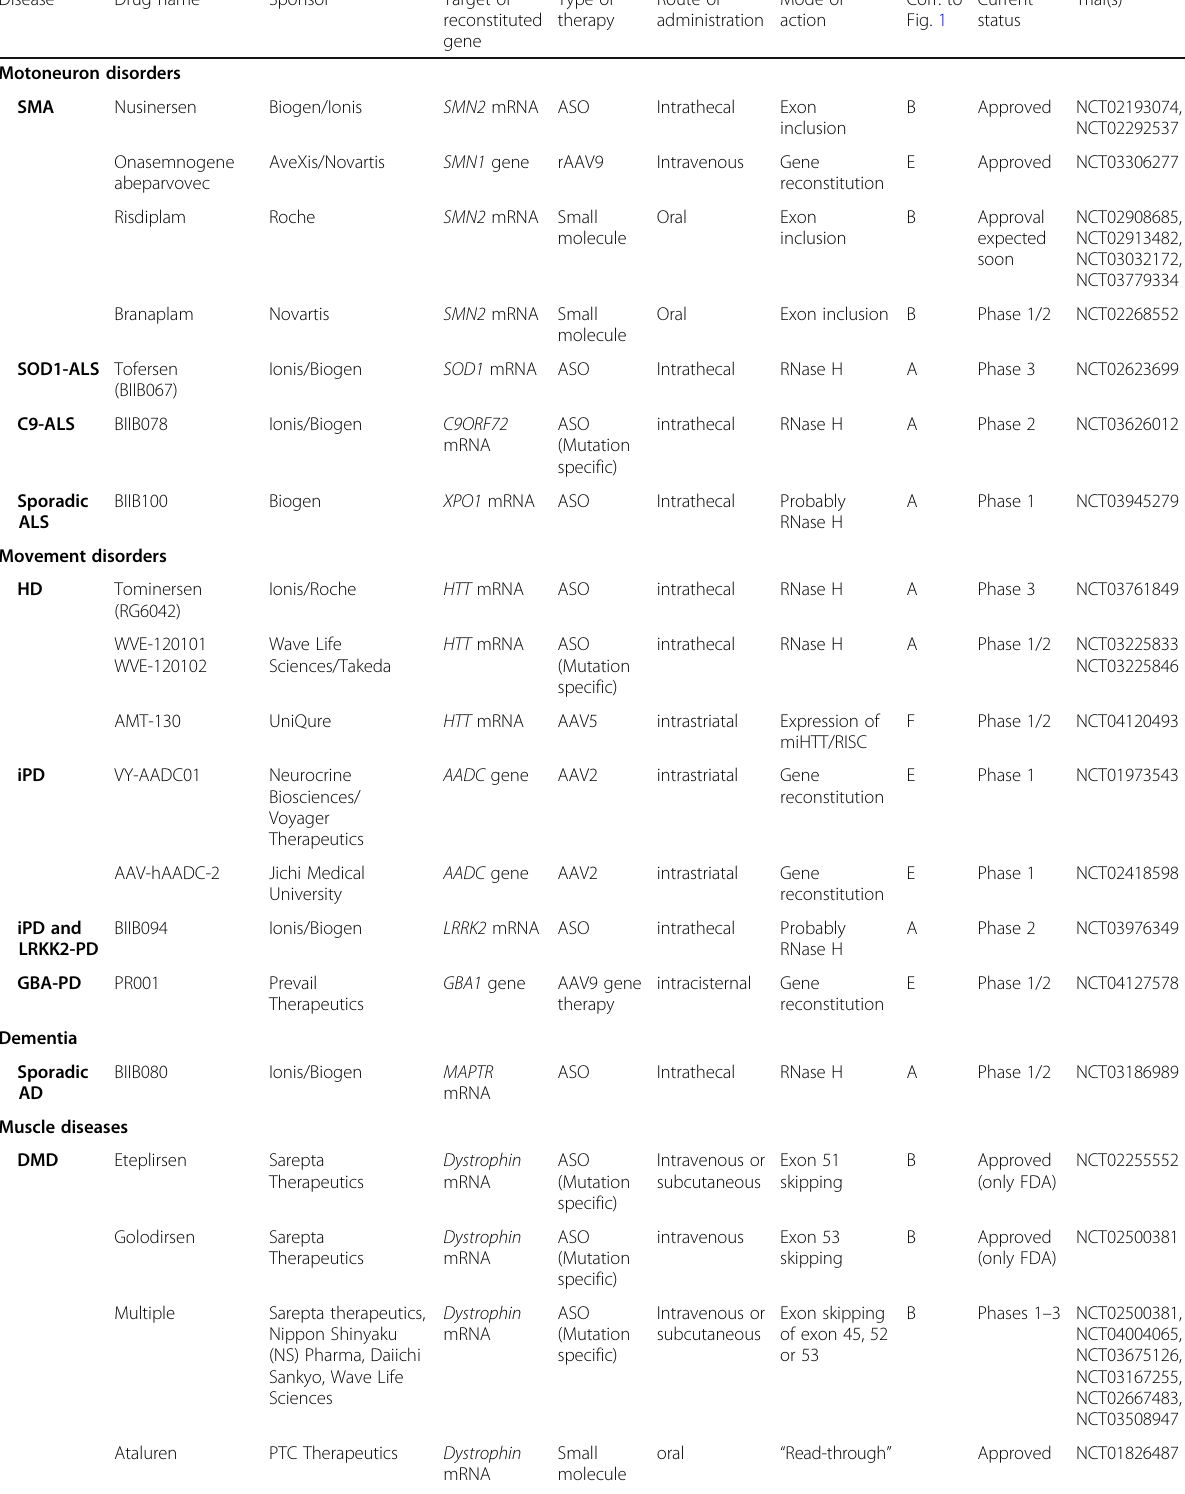
Table 1 Gene specific therapies approved for treatment or tested in clinical trials